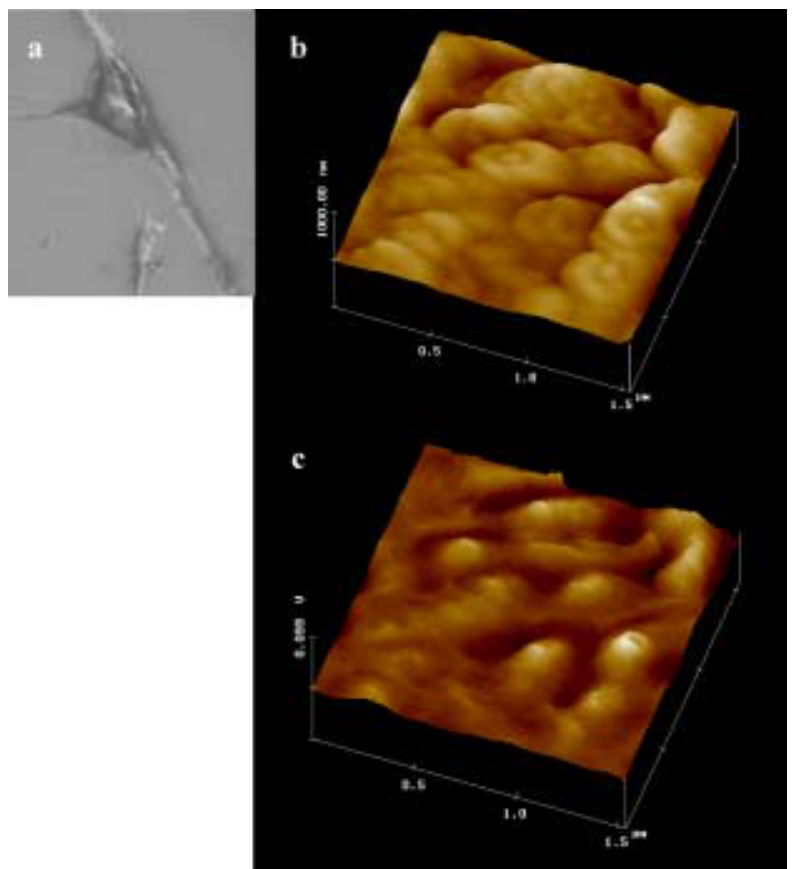
Fig. 2. (a) Far-field image of a cell of the breast cancer cell line T-47D (control without E 2 treatment) detected with 40 × magnification; the typical polygonal shape is visible. (b) Near-field topographic image of a cellular surface section of the same breast cancer cell showing typical rosettes; (c) near-field transmission light image of the same surface section. Regions of the rosettes correspond to low absorbance